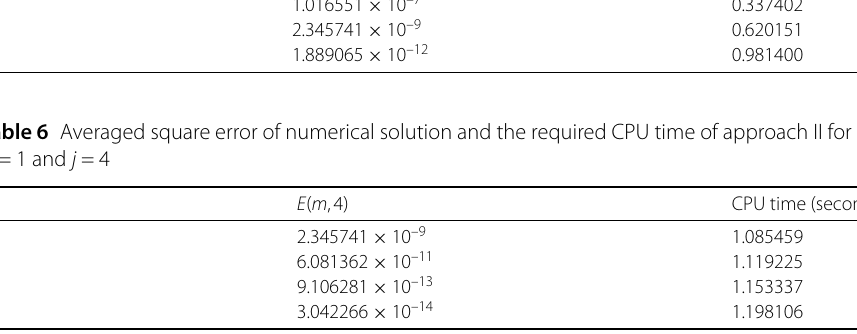
Table 7 Comparison of absolute errors of approximated solutions utilizing approach III for λ = 0.5 and λ = 1 λ =